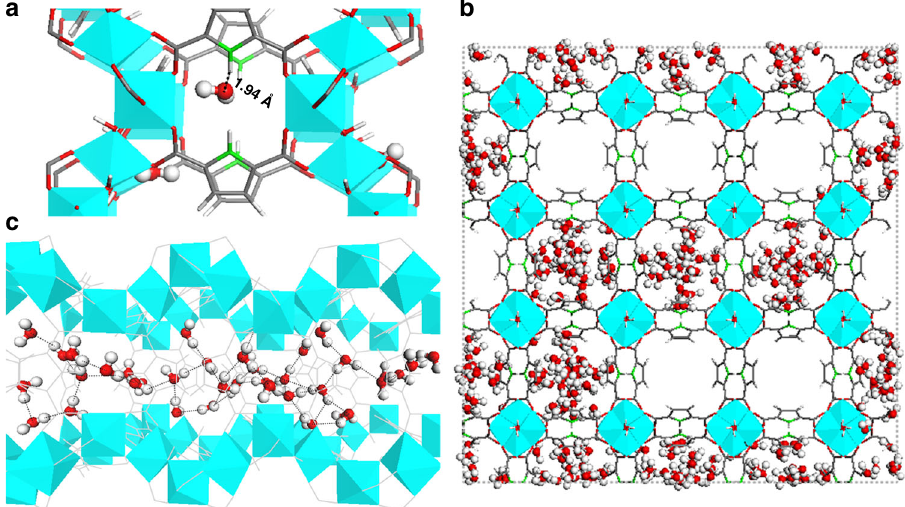
Fig. 3 Microscopic water adsorption mechanism in KMF-1. Preferential arrangements of the water molecules in the channel of KFM-1 at different P / P 0 ( a ) 0.10, ( b ) 0.14, and ( c ) 1.00. a Interaction between the very fi rst adsorbed water molecules and the NH function of the linker. b Gradual fi lling of the porosity with water molecules adsorbed channel by channel. c Formation of a strong H-bond network when the pore is saturated, the black dash lines indicating the H